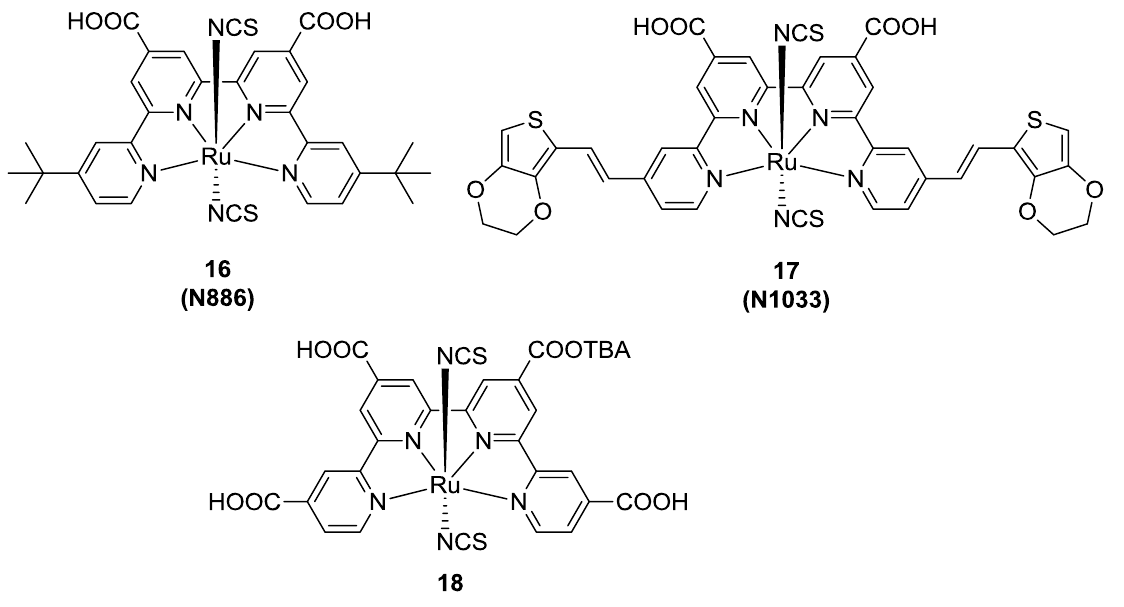
Figure 13. Qtpy complexes investigated by Barolo et al. [68,91,92].